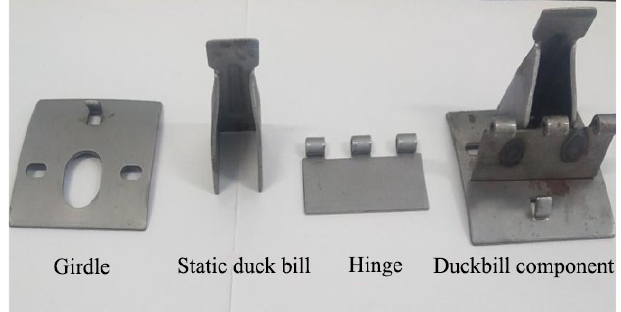
Figure 2. Physical drawing of the duckbill welding parts of the cotton seeder. Table 1. Structural parameters of duckbill welding parts.